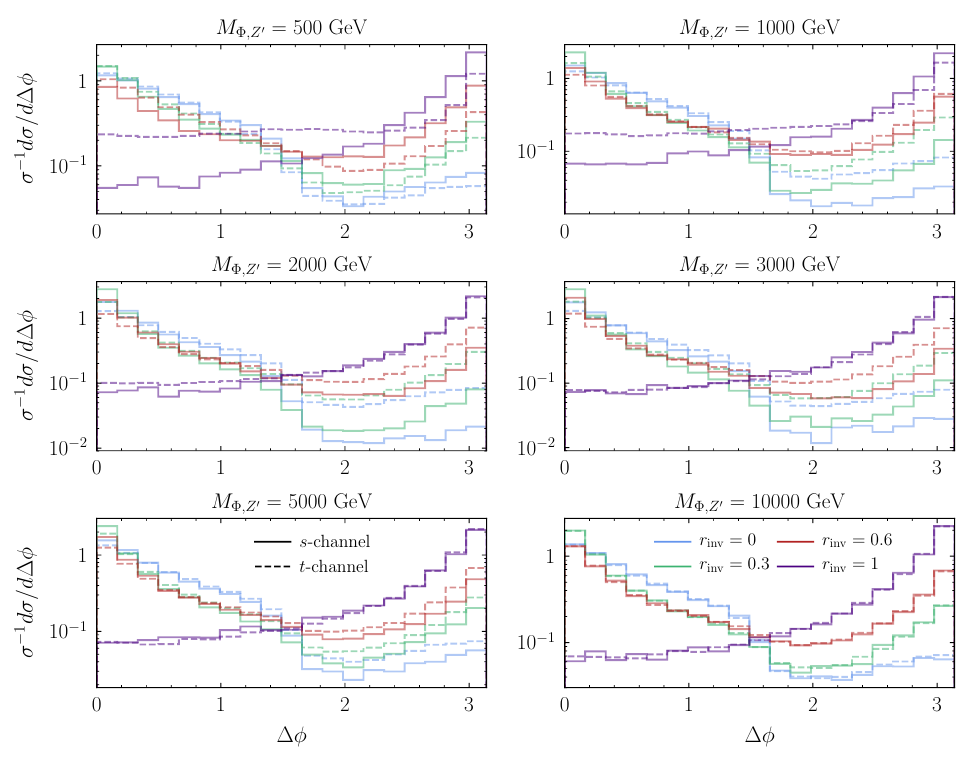
Figure 13 . (cid:1) (cid:30) distributions for the s - and t -channel models for a range of mediator masses and r is due to di(cid:11)erent production channels along with modi(cid:12)cations to the m (cid:31) (cid:22) (cid:31)